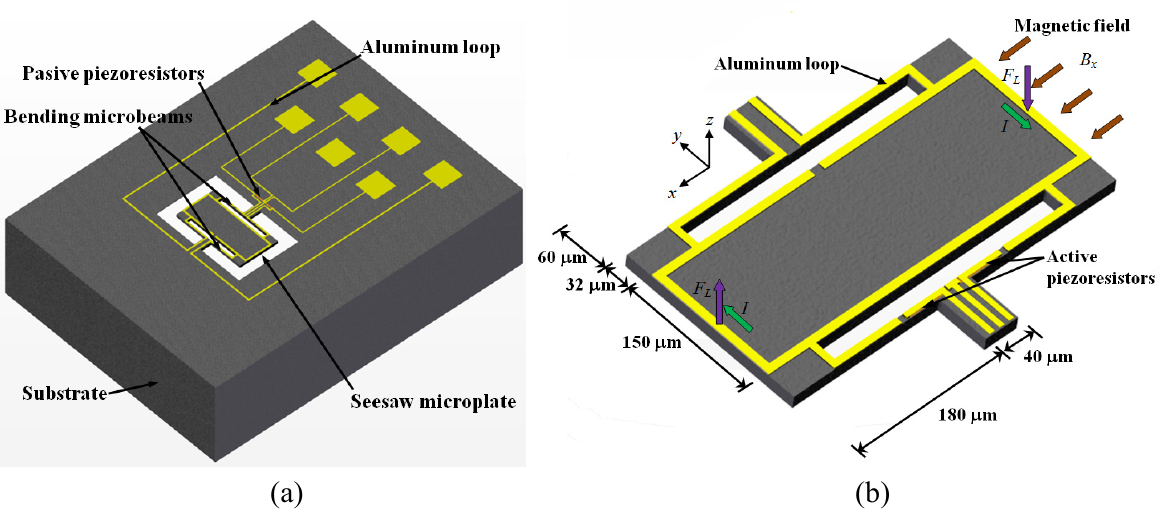
Figure 7. A 3D Schematic view of the (a) structural configuration and (b)